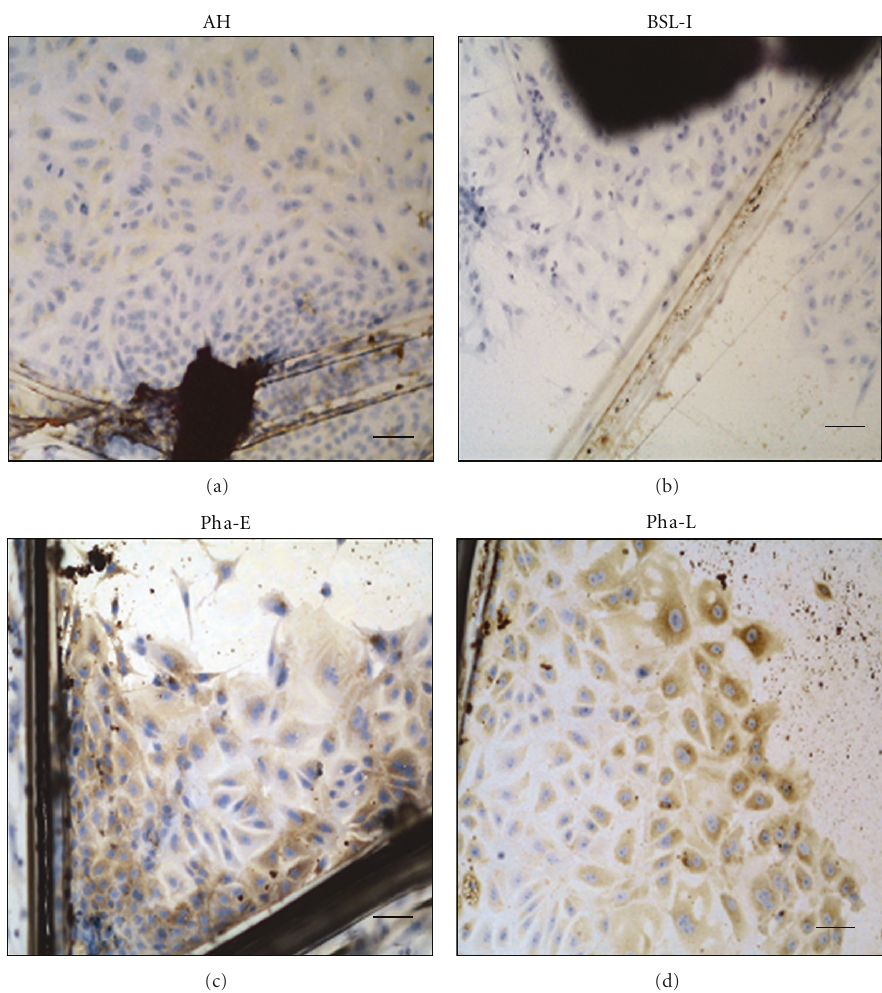
Figure 4: Lectin staining characteristics of cell outgrowths, 10 days after explanting. The majority of cells stain for Pha-E and Pha-L, lectins specific for the proximal tubular epithelium. (a) Arachis hypogaea (AH); (b) Bandeiraea simplicifolia I (BSL-I); (c) Phaseolus vulgaris erythroagglutinin (Pha-E); (d) Phaseolus vulgaris leukoagglutinin (Pha-L). Scale bar = 25 μ